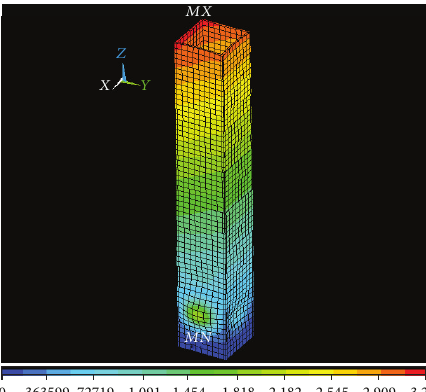
Figure 27: Typical computed deformed shapes of HS-50-20-T2.